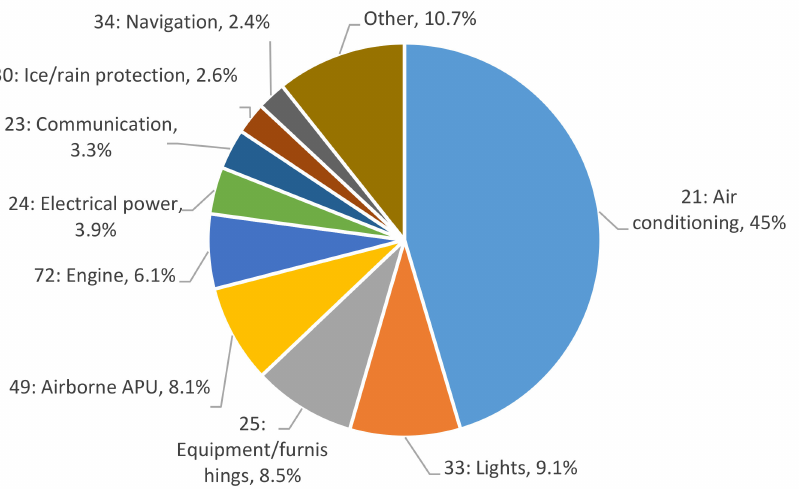
Figure 2. ATA chapters assigned by airlines to fumes/smoke reports, 2002–2011 ( n =